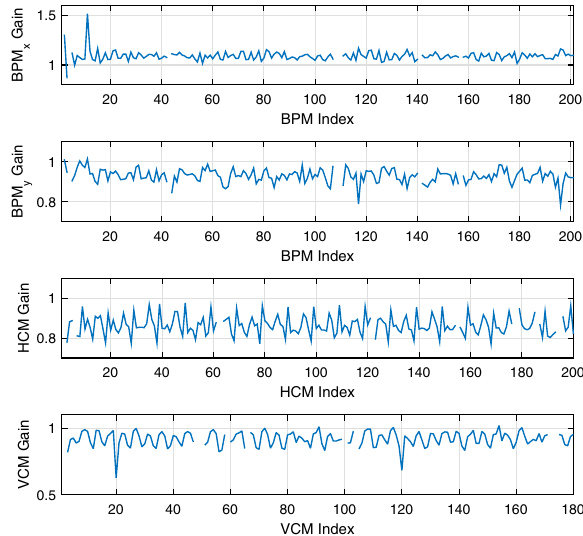
FIG. 11. BPM and dipole corrector magnet gains found by fitting to the OEORM. The method is able to identify the different gain of the flanking BPMs in the first achromat. In the case of the BPMs the “ 1 ” corresponds to the theoretical gain of a standard MAX IV 3 GeV storage ring BPM, while in the case of the correctors 1 corresponds to the kick strength given by magnetic measurements.